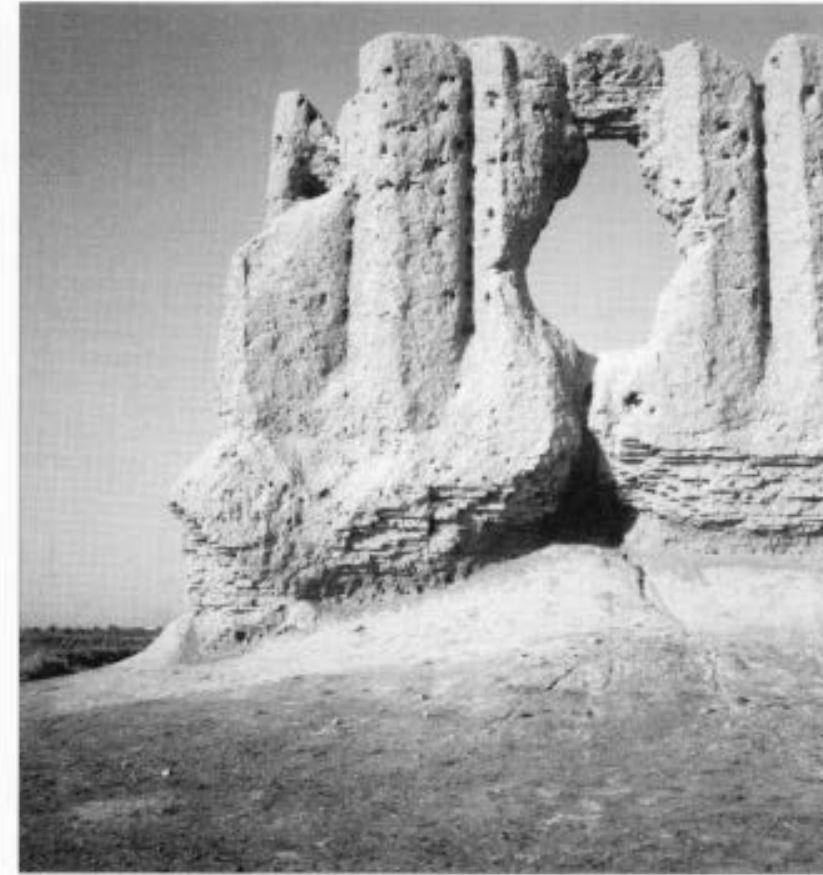
Figure 2 Decayed apostle, Wells Cathedral. The limestone reacts with acidic air pollut­ ants to give salts, which then cause further